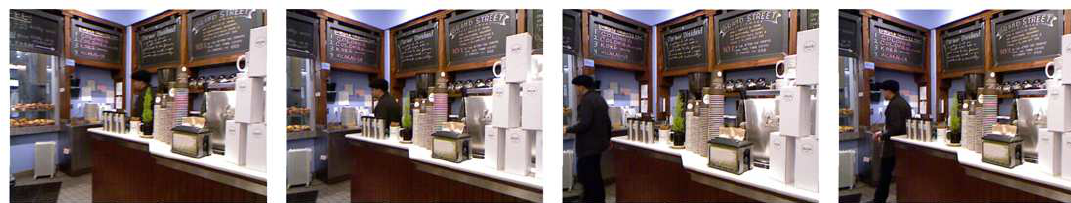
Figure 1. Several keyframe images selected by the traditional visual SLAM system are almost the same, which brings redundant information when constructing maps and reduces the efficiency of mapping.